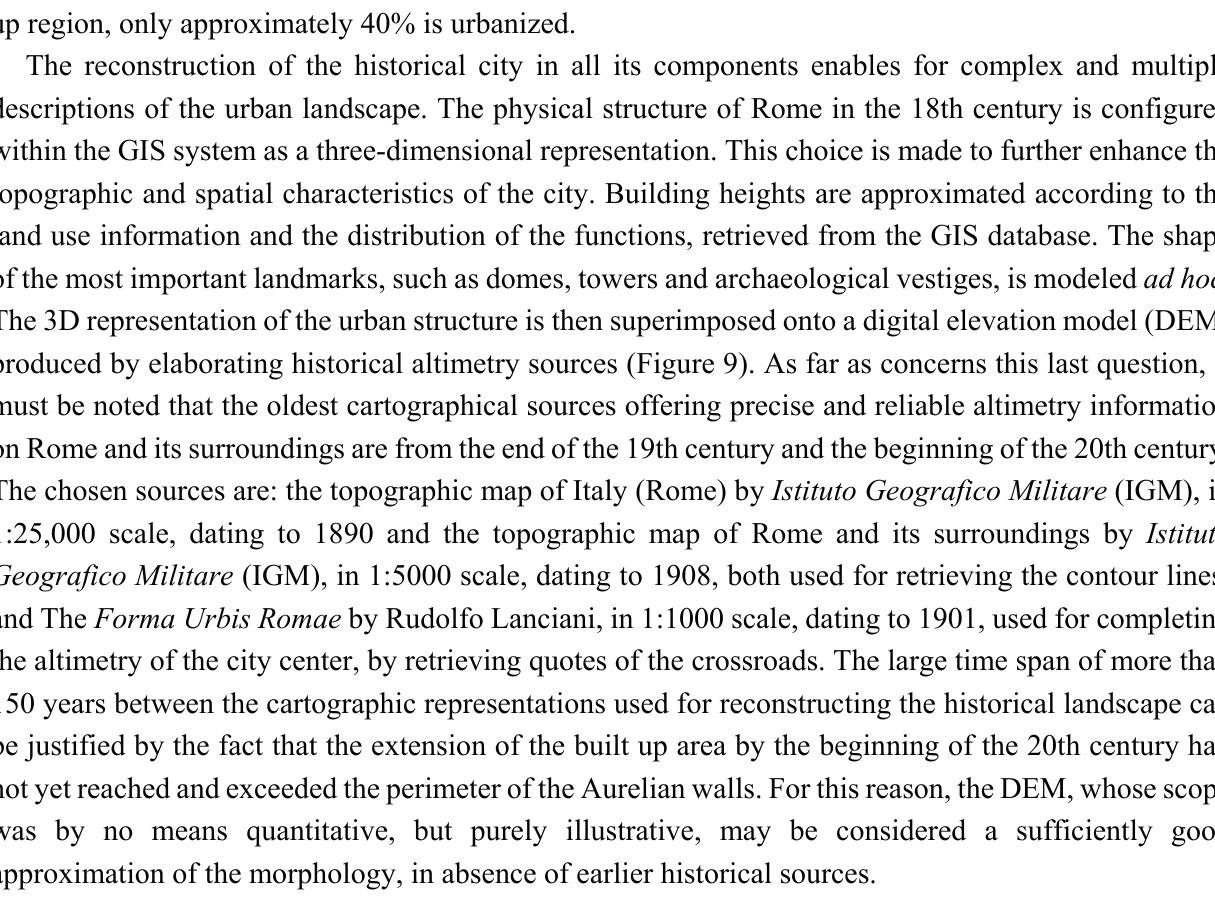
Figure 9. Physical structure of Rome in the 18th